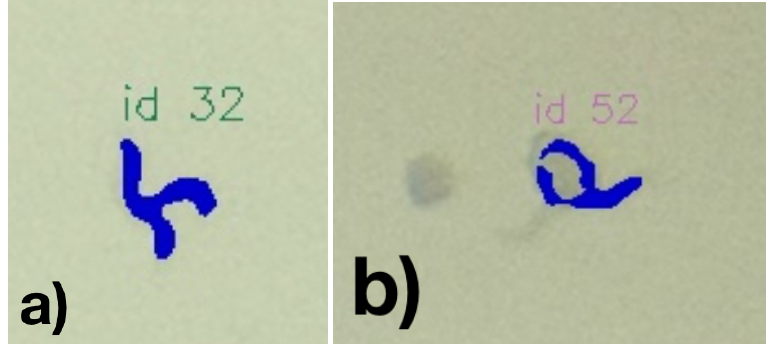
Figure 12. ( a ) Example of two crossing nematodes—detected as a single one and ( b ) an erroneous segmentation due to a worm being in a